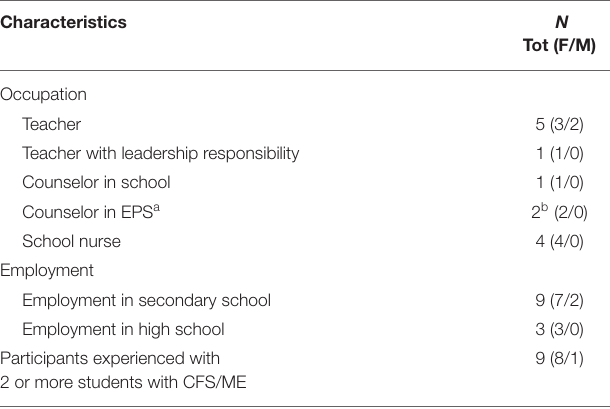
TABLE 1 | Characteristics of the informants.